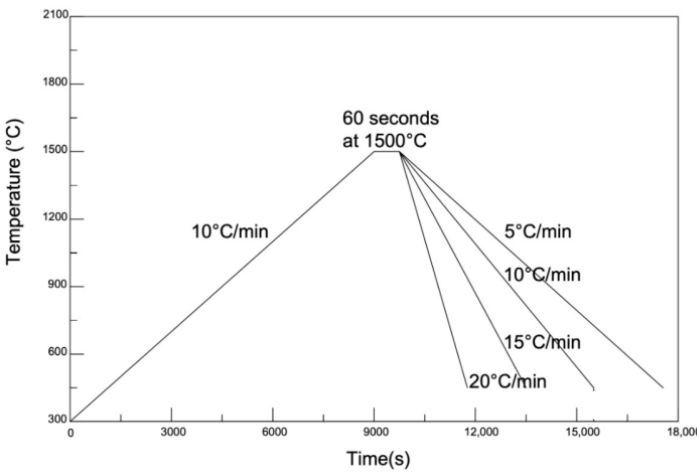
Figure 3. Thermal profile of CCT experiments.